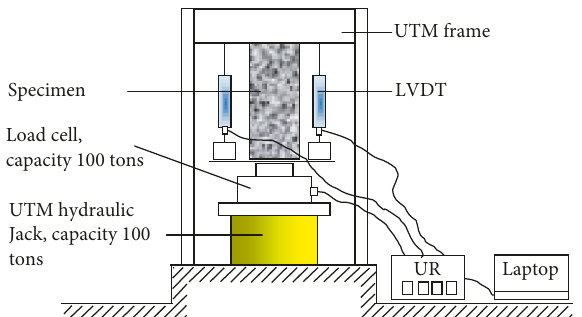
Figure 3: Schematic of test setup. UR LVDT linear variable displacement transducer. (cid:31)